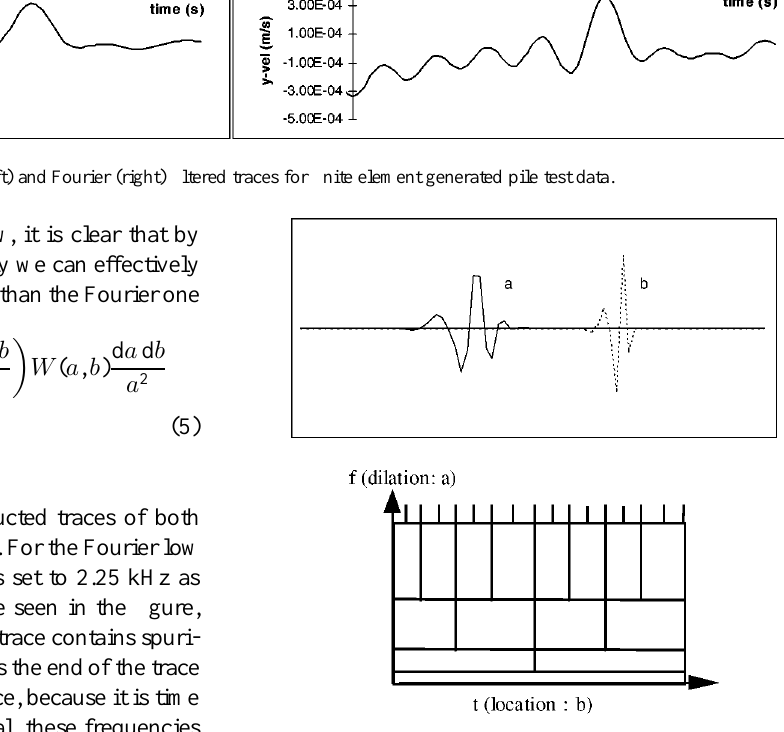
Fig. 4.A Daubechies, D(8), wavelet (b) having undergone translation and dilation from wavelet (a), top. Also a diagrammatic representa- tion of the frequency (dilation) and time (location) resolutions for an orthonormal, complete wavelet with location and dilation halving at each consecutive level, bottom. Each enclosed area contains one